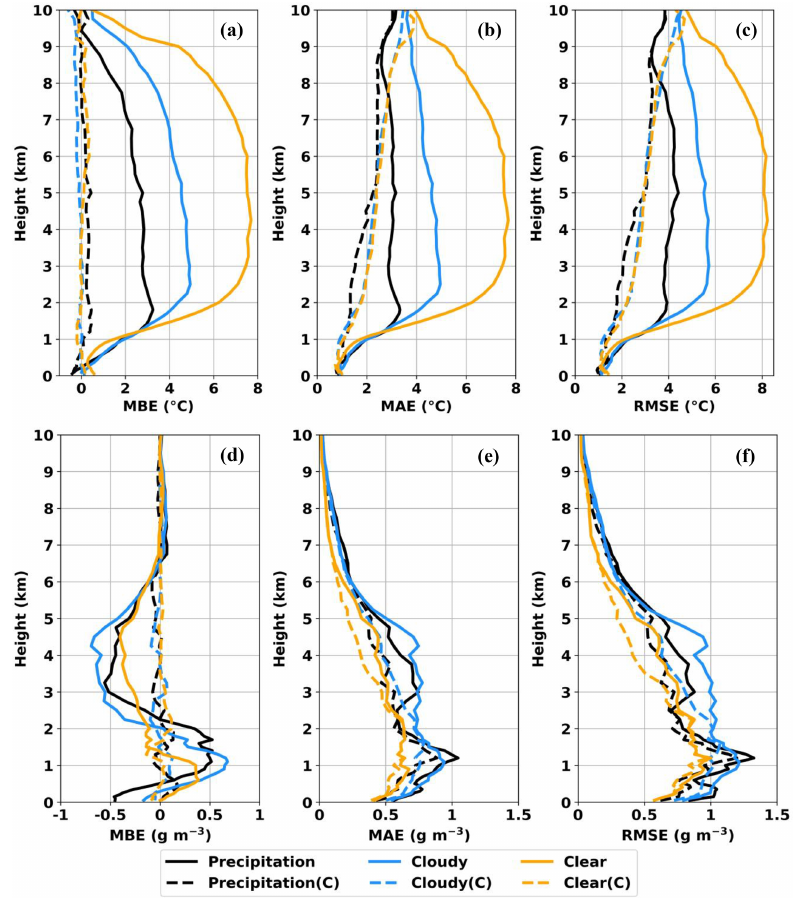
Figure 11. Vertical profiles of MBE, MAE, and RMSE for original and corrected (C) MWR-measured (a–c) temperature and (d–f) water vapor density during three weather conditions from the NYSM Profiler Network site at Albany.